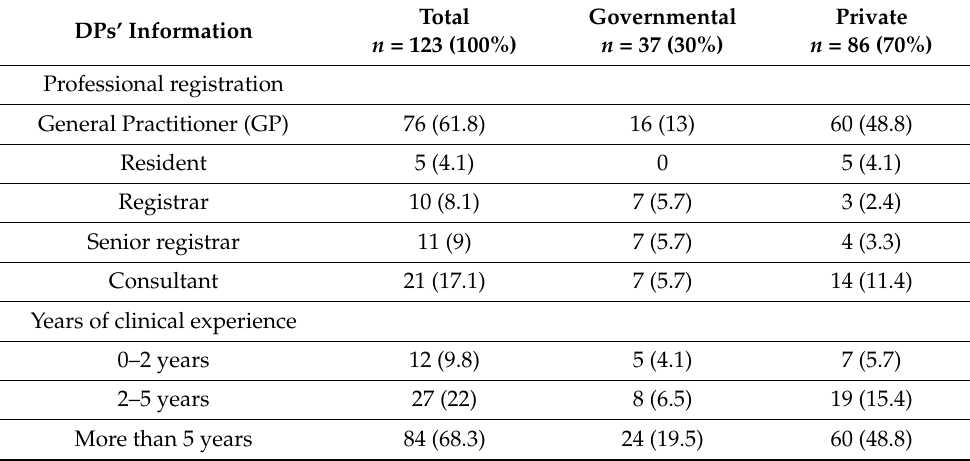
Table 1. The information of the dental practitioners (DPs) participated in the